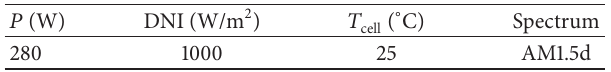
Table 2: Maximum power of the high concentrator photovoltaic module considered at standard test conditions